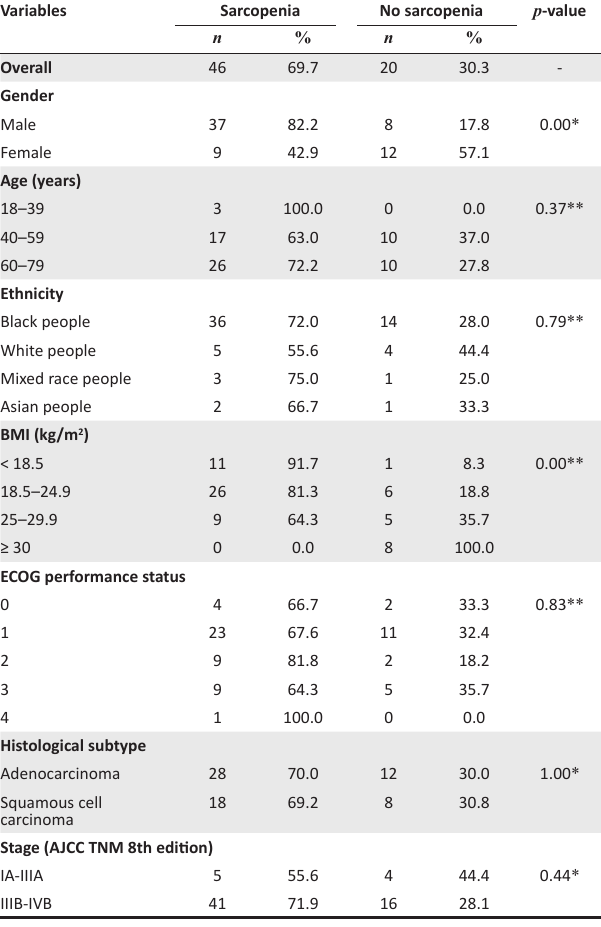
TABLE 2: Sarcopenia prevalence. Variables